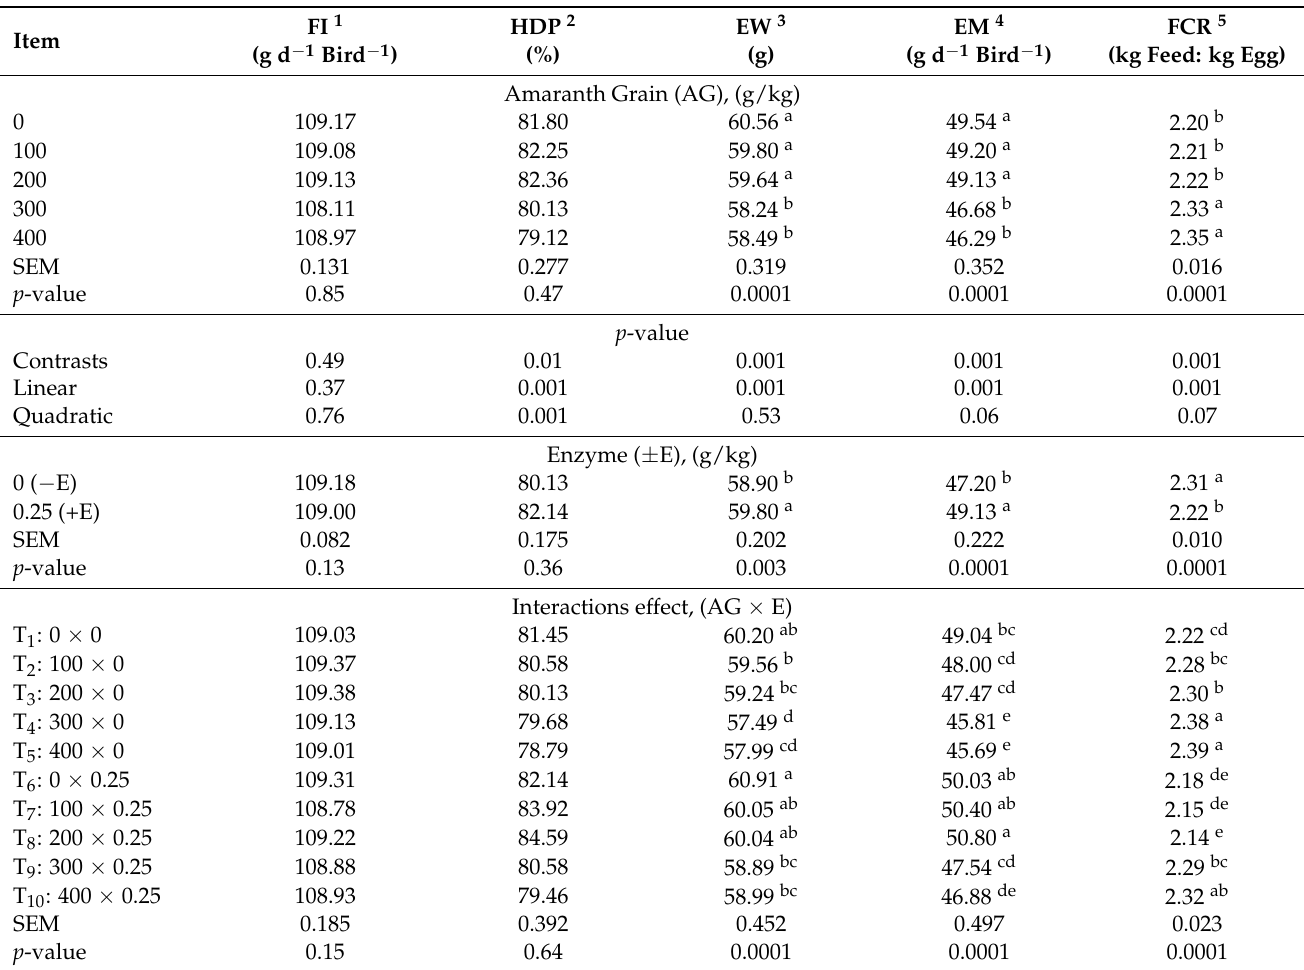
Table 3. Main effects of amaranth feeding, enzyme additionand interaction between amaranth feeding and enzyme addition on productive performance of laying hens.